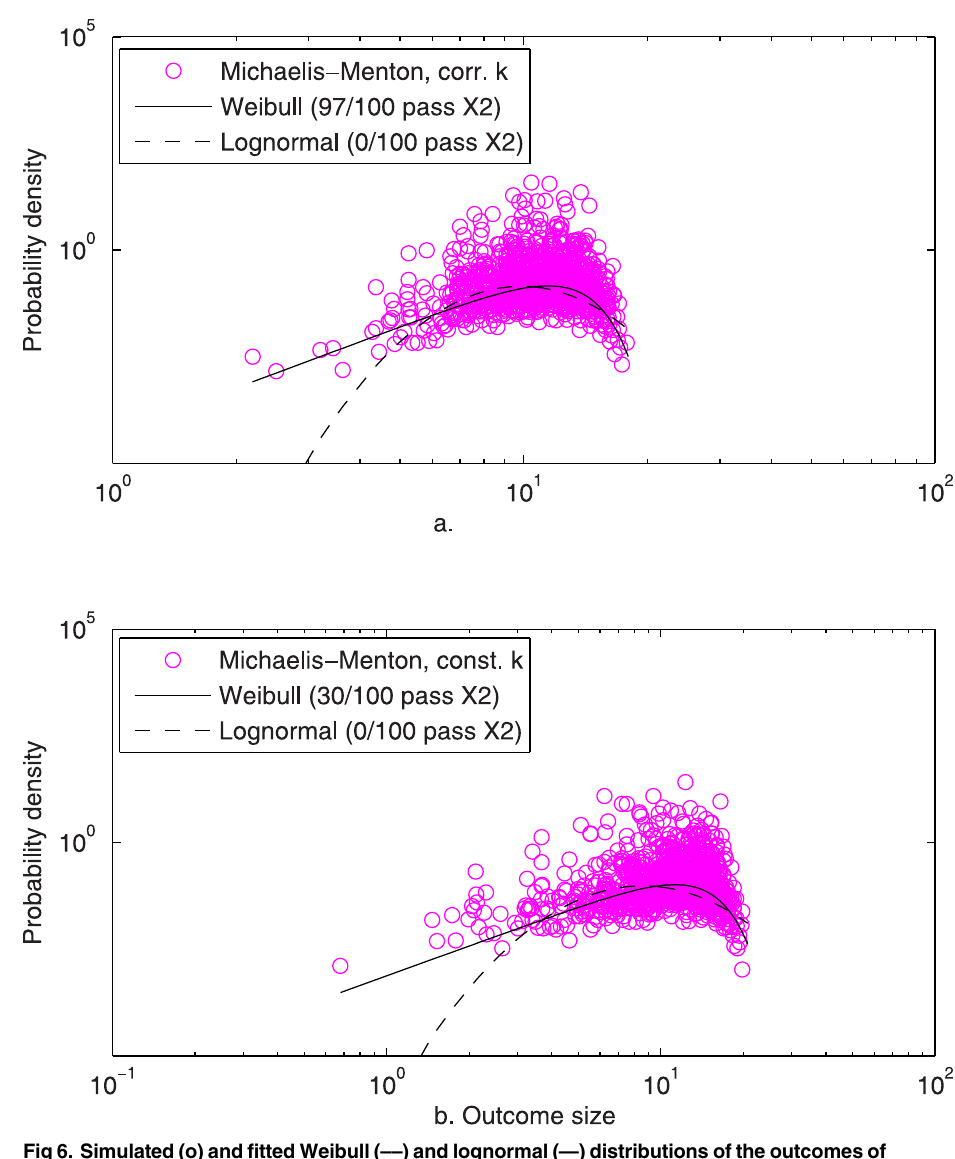
Fig 6. Simulated (o) and fitted Weibull ( –– ) and lognormal ( — ) distributions of the outcomes of Michaelis-Menten saturation kinetics, with maximum-rate constant simulated as (a) partially correlated standard exponential RVs, and (b) perfectly correlated (identical) standard exponential RVs, both simulated as described for Fig 1. [Conditions: N = 1000, MLE parameter estimates]